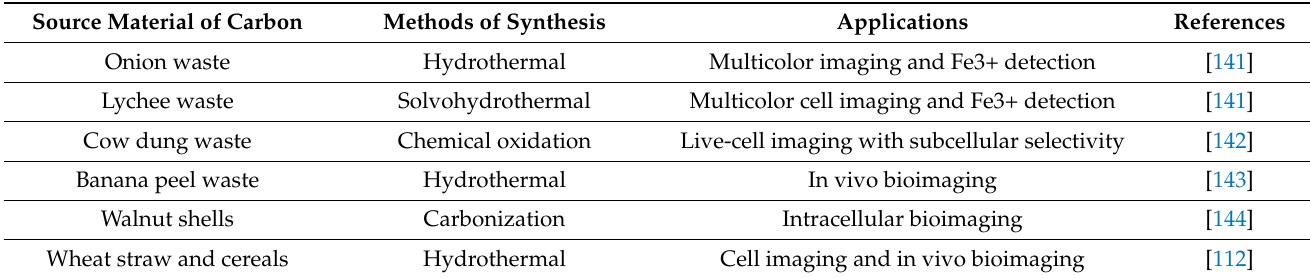
Table 10. Applications of C-dots in bioimaging.